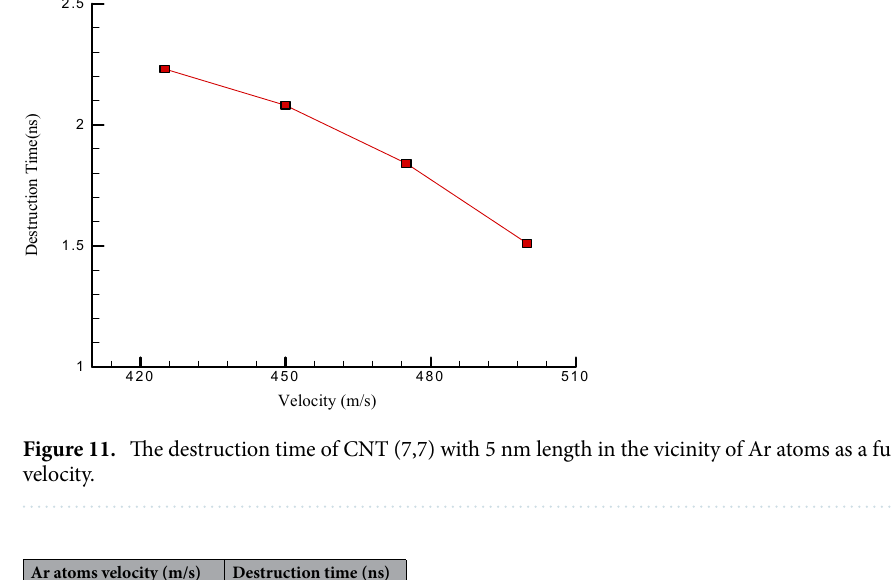
Ar atoms velocity